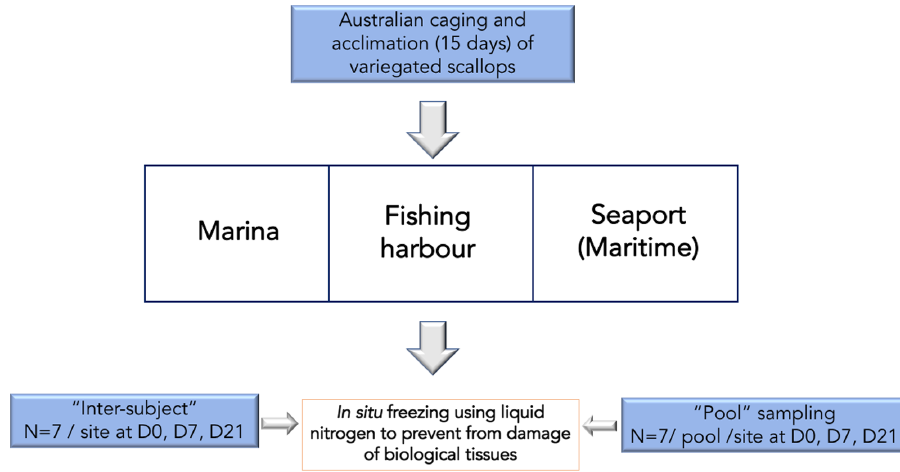
Fig 2. Integrative approach of sampling strategies of bivalves M . varia at all sampling sites in April